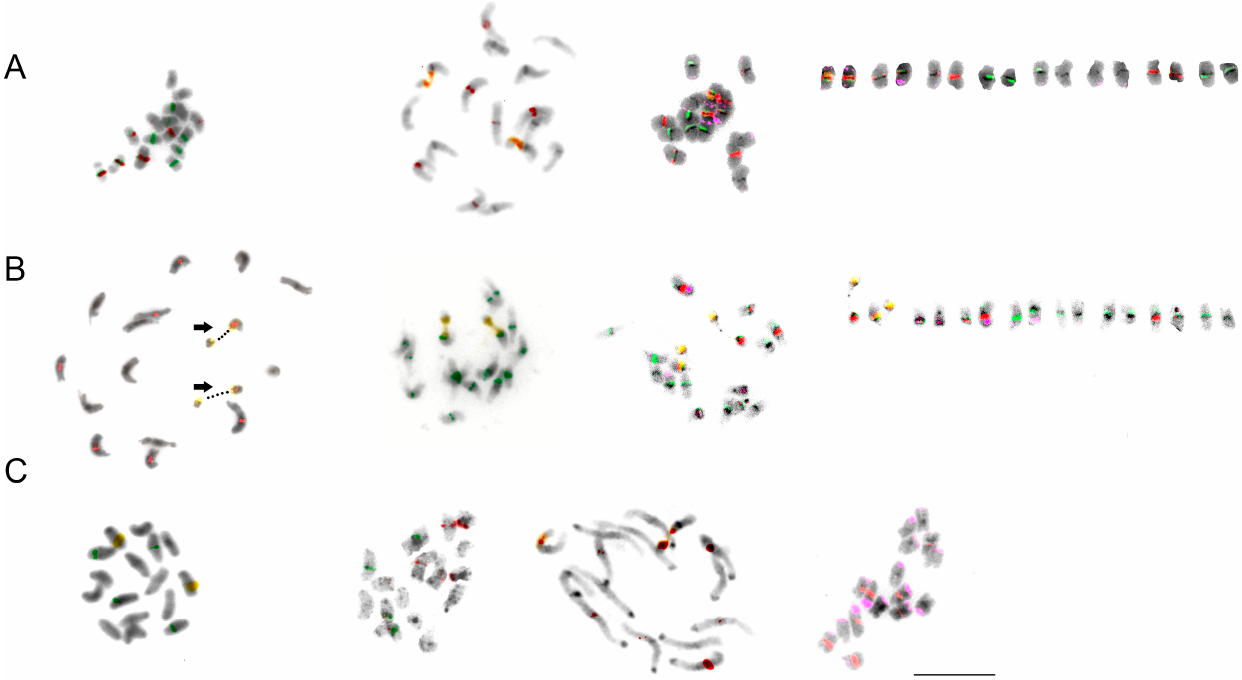
Figure 7. Hybridization patterns of selected T. medium -specific repetitive elements and 5S and 26S rDNA fluorescent probes on metaphase chromosomes of ( A ) T. alpestre , ( B ) T. pignantii , and ( C ) T. rubens . Centromeric repeat TrM378 (red), subtelomeric repeat TrM179 (pink), 5S rDNA (green), and 26S rDNA (orange). Black dots and black arrows indicate highlighted nucleolar organizer regions (NORs). Scale bar = 10 μ m.